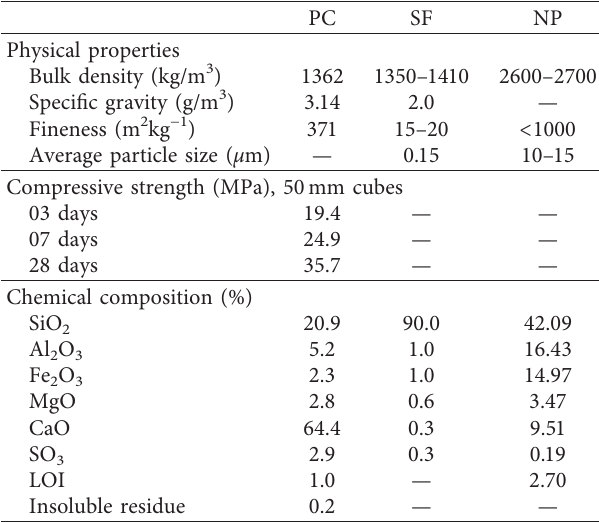
Table 1: Physicochemical properties of the CMs.